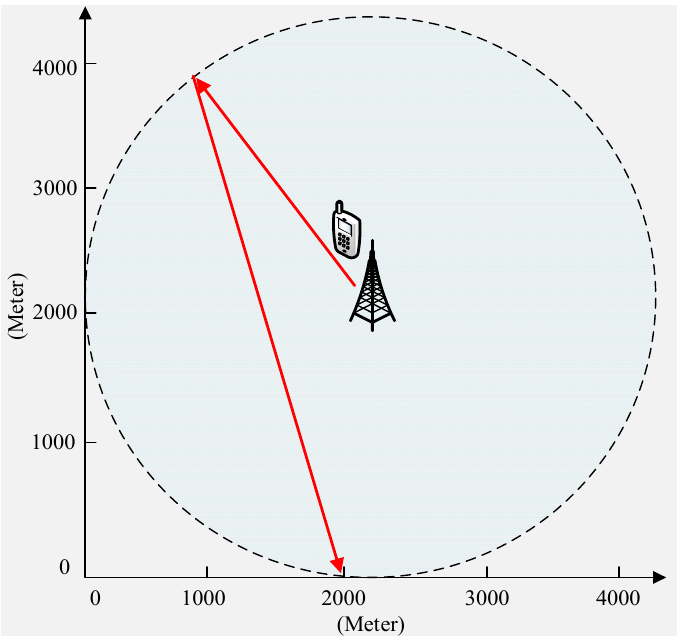
Figure 14. Mobile moving path for deep learning model performance analysis.